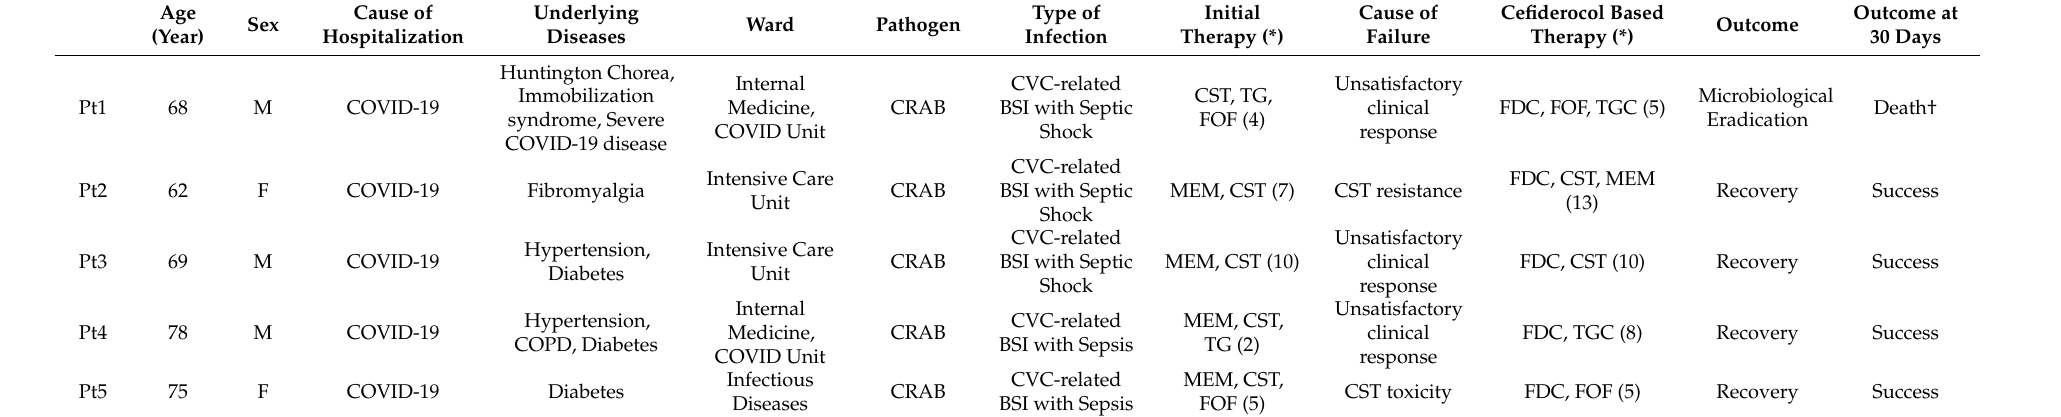
Table 1. Characteristics of patients of Group 1, classified as “critically